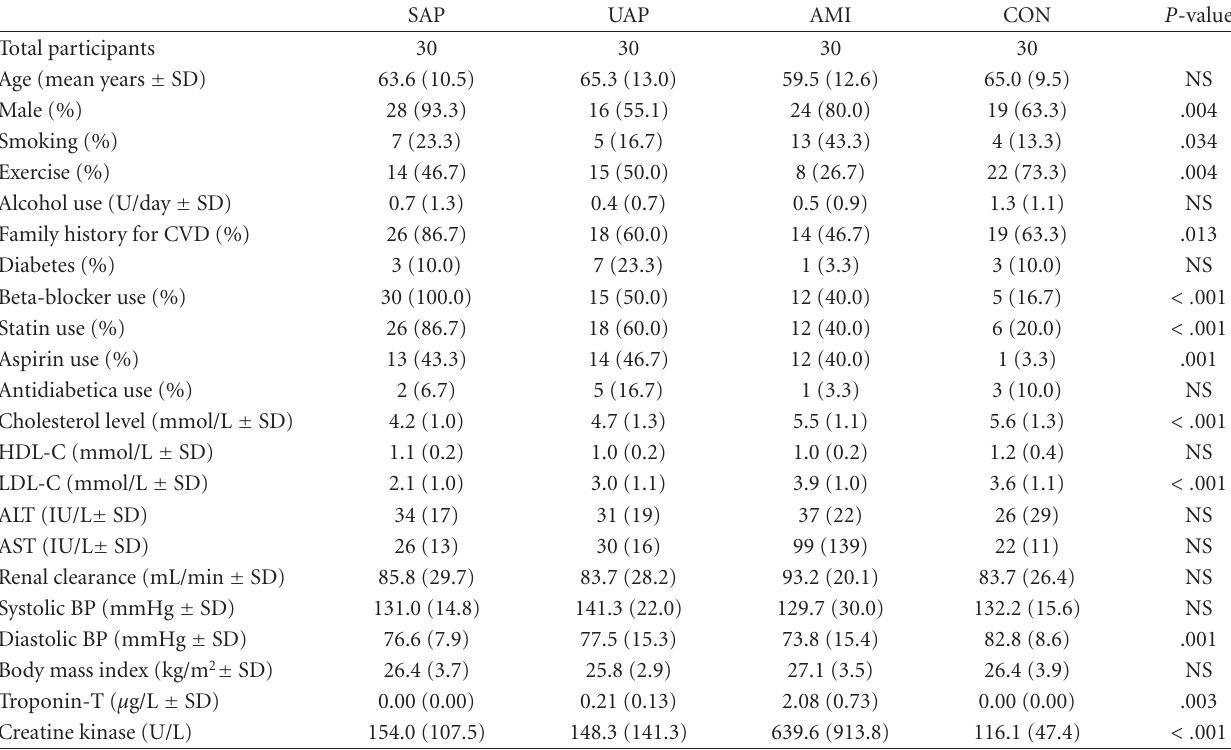
Table 1: Baseline patient characteristics per study